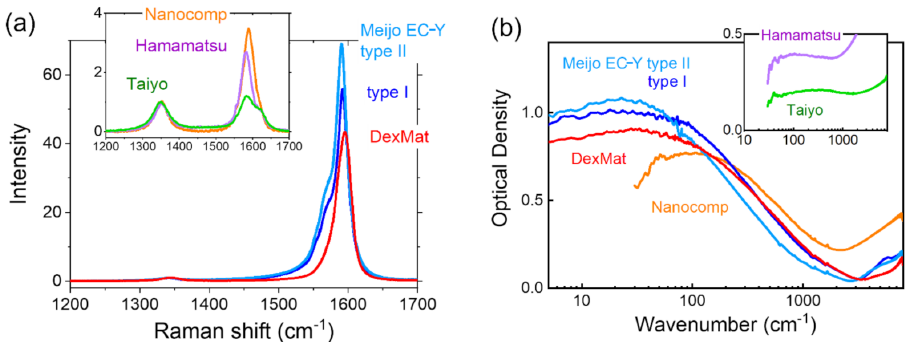
Figure 5. ( a ) Resonance Raman spectra and ( b ) far-infrared spectra of the constituent CNTs in